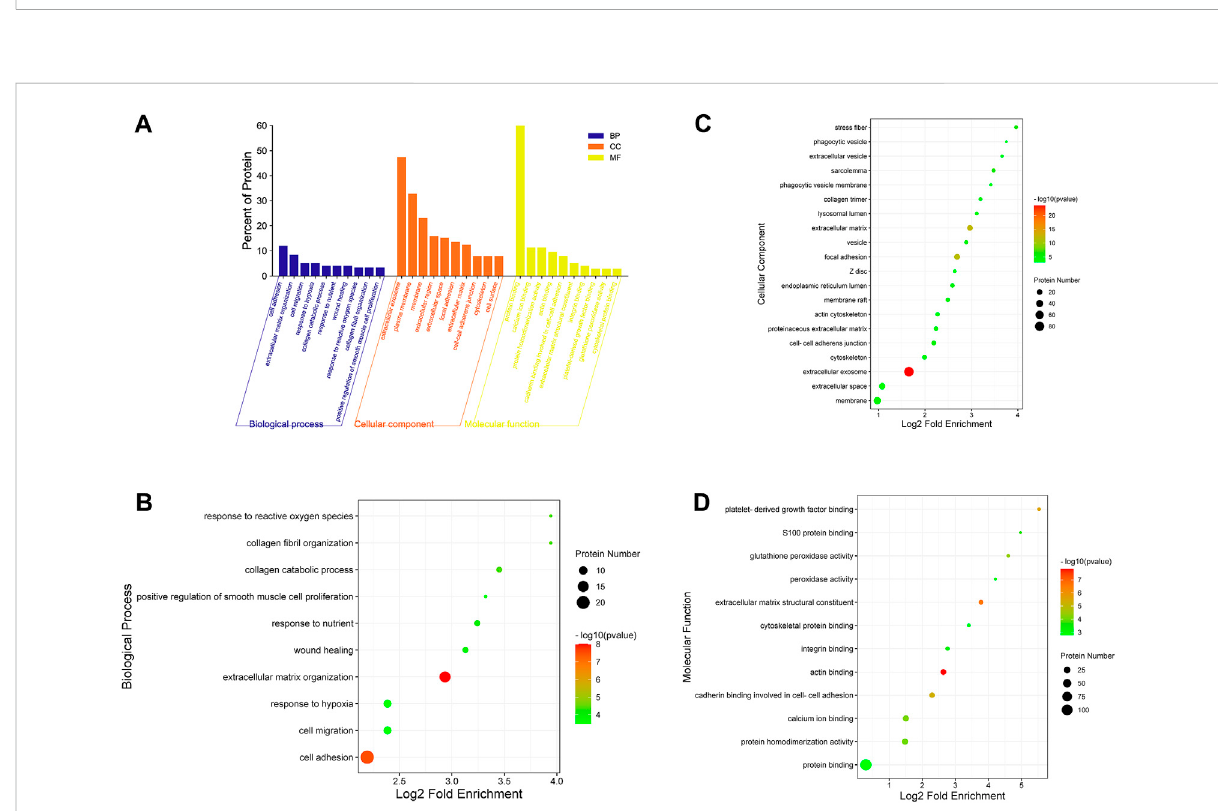
FIGURE 7 GO annotation classi fi cation analysis in biological process (BP), cellular component (CC) and molecular function (MF). (A) The top 10 signi fi cantly richer terms in the BP, CC, and MF categories. (B) Enrichment bubble plots of DEPs in BP. (C) Enrichment bubble plots of DEPs in the top 20 CC. (D) Enrichment bubble plots of DEPs in MF. p < 0.05, FDR <